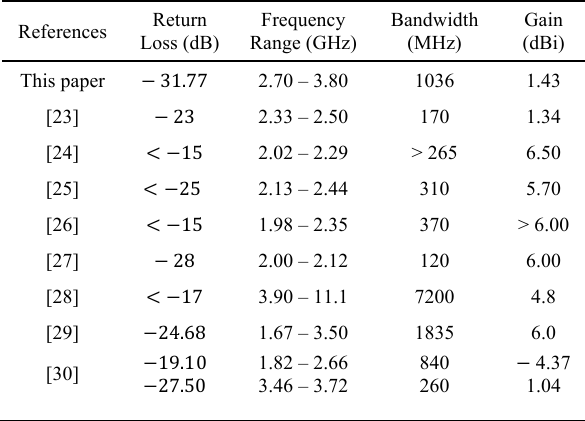
TABLE II. Comparisons of results from other S-Band